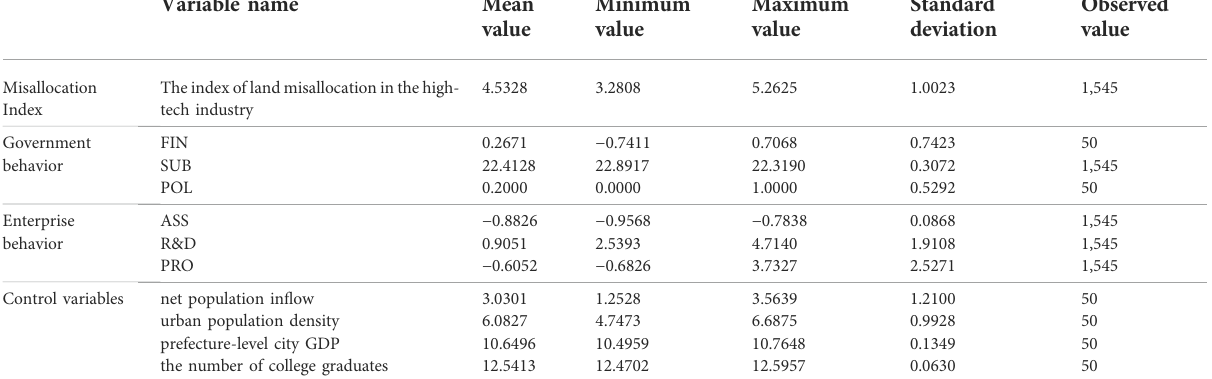
TABLE 2 Descriptive statistics of